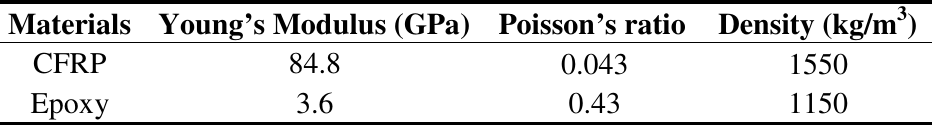
Table 2. Properties of the CFRP laminate and